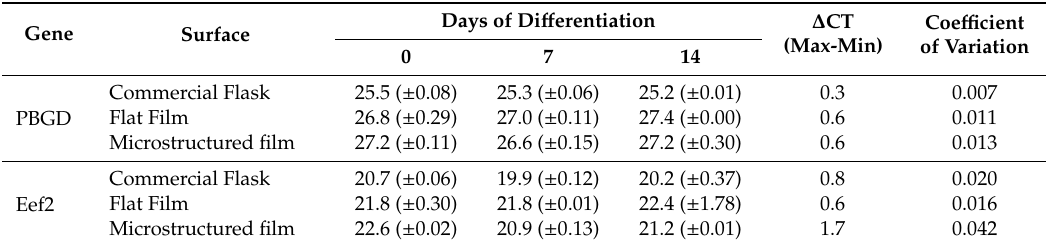
Days of Di ff erentiation ∆ CT